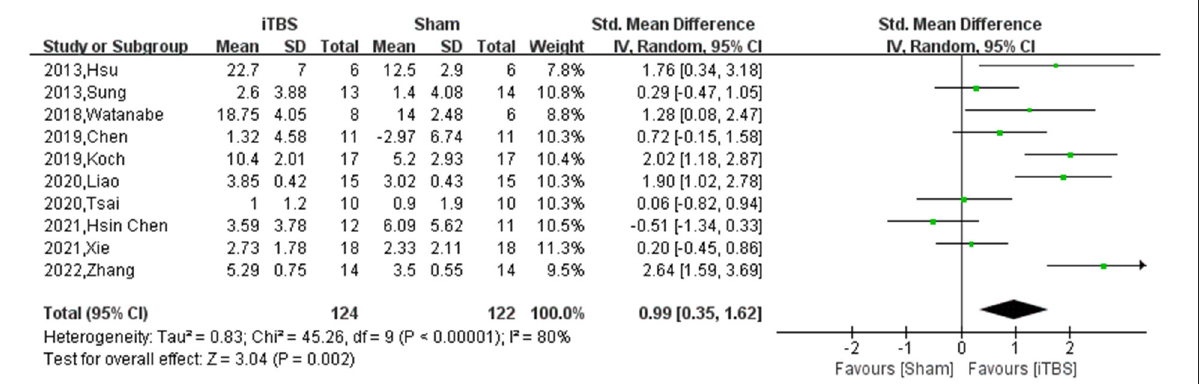
enrolling 91 patients were pooled to analyze the MAS change from baseline in the iTBS group and the sham group. ITBS could not significantly increase MAS score compared with the sham group (Study number = 4, Std.MD = − 0.71 95% CI = − 1.88– 0.47, P = 0.24; Figure 4). Sensitivity analysis of overall MAS change from baseline showed that all consolidated results were stable (Supplementary Figure